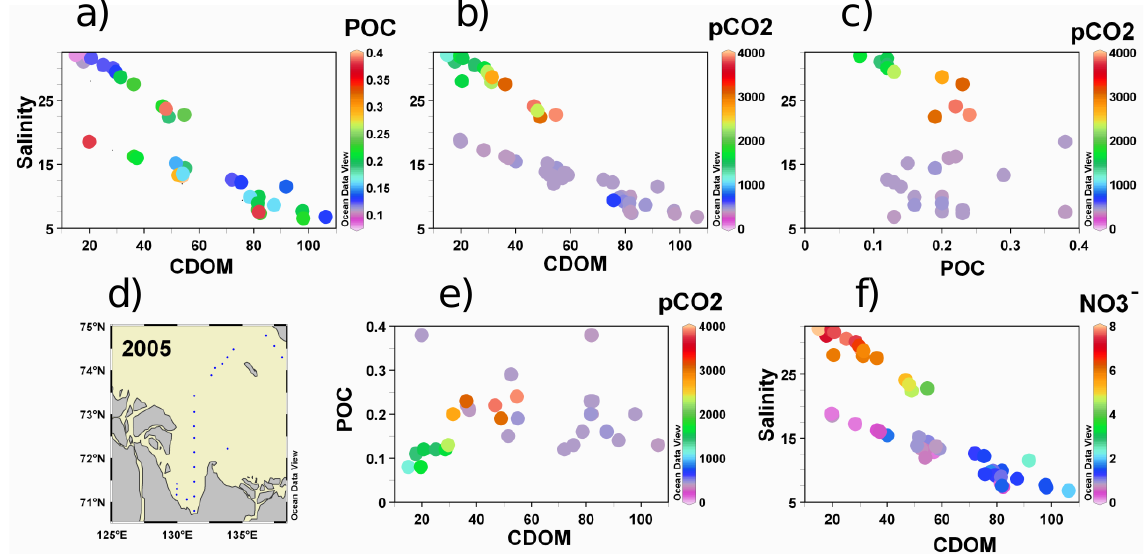
Fig. 9. Plots of particular organic carbon (POC, mgL − 1 ) (a) and partial pressure of CO 2 ( p CO 2 ,µatm) (b) color-coded by salinity and colored dissolved organic matter (CDOM, mgm − 3 ); p CO 2 color-coded by POC (c) and CDOM (e) ; nitrates (NO − salinity and CDOM (f) . Position of transect conducted in September 2005 is shown in (d) .